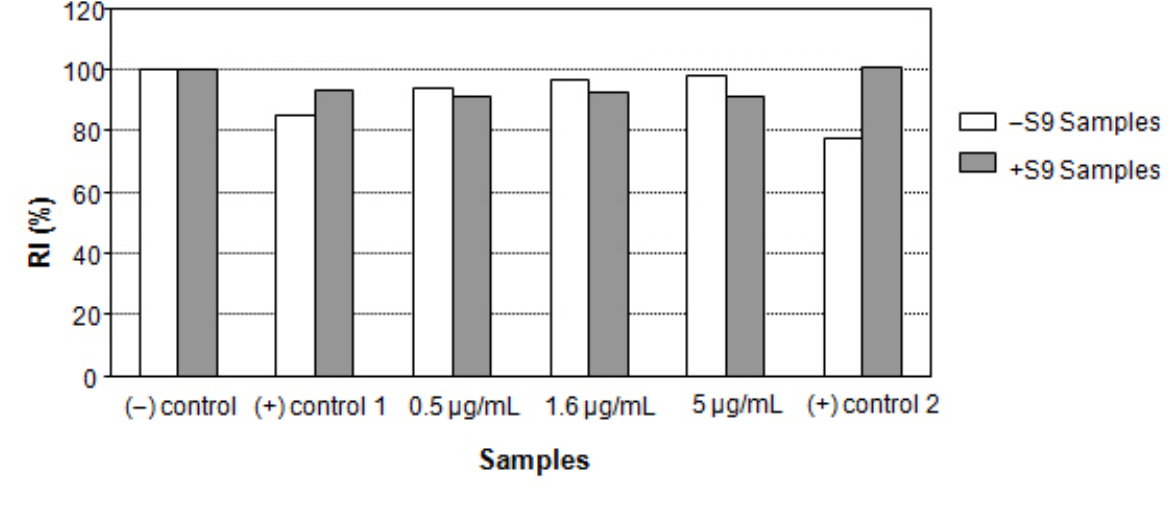
Figure 1. Micronucleus test (CHO-K1 line) and replication Index (RI, mean expressed as percentage). Cells were treated with the extract in the presence (+) and absence (-) of metabolic activation (S9). The ( – ) control corresponds to the culture medium; (+) control 1 corresponds to benzo(a)pyrene (in experiments with S9) and mitomycin C (in experiments without S9); (+) control 2 is related to colchicine in the absence of S9 and to cyclophosphamide in the S9 treated cells. CHO: Chinese hamster